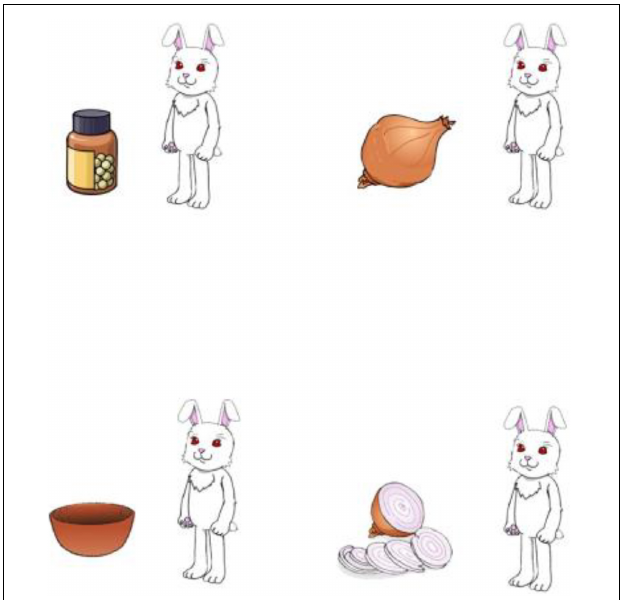
FIGURE 1 | Example visual stimulus. Participants heard sentences such as “ The rabbit has a bowl, a bottle of pills and an onion. She was going to